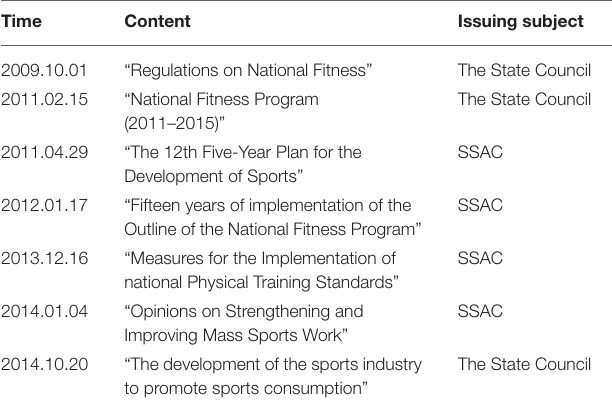
TABLE 2 | Relevant contents of the in-depth development stage of national fitness.